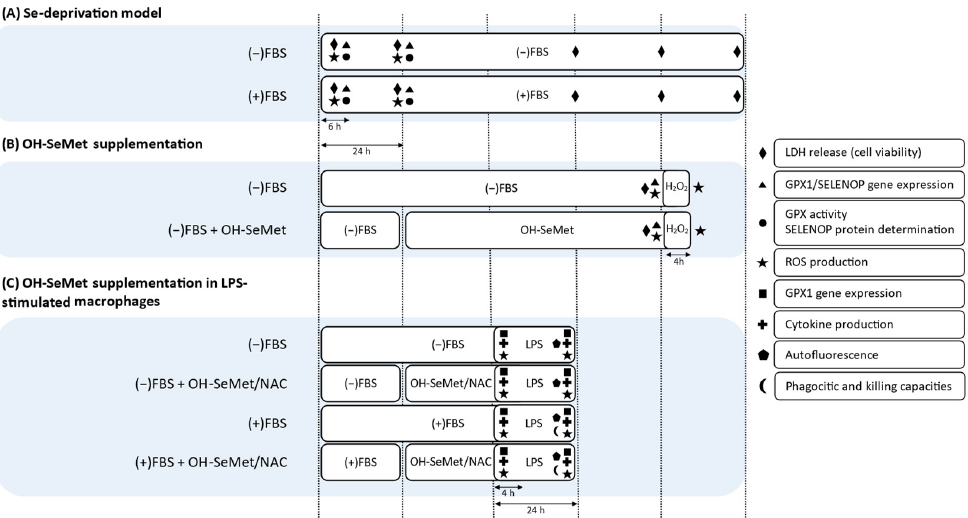
Figure 1. Experimental design for the Se-deprivation model, OH-SeMet supplementation, and LPS-stimulation model. ( A , B ) are explained in Section 2.4 and ( C ) in Section 2.5. FBS, fetal bovine serum; GPX, glutathione peroxidase; LDH, lactate dehydrogenase; LPS, lipopolysaccharide; NAC, N-acetyl-L-cysteine; OH-SeMet, 2-hydroxy-(4-methylseleno)butanoic acid; ROS, reactive oxygen species; SELENOP, selenoprotein P.